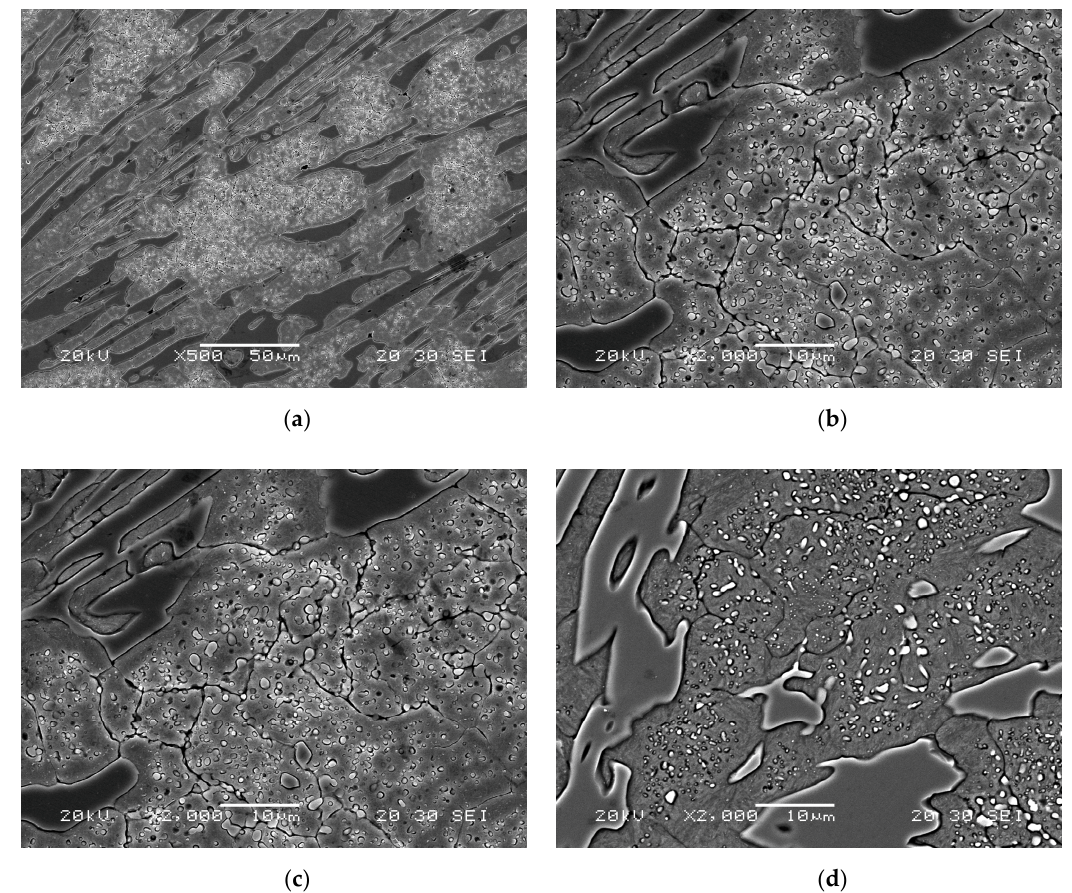
Figure 5. Comparison of the density of secondary carbides in samples subjected to destabilization heat treatments of 4 h and quenching in air or oil. Scanning electron microscope; ( a ) quenching in air. 500×; ( b ) quenching in air. 2000×; ( c ) quenching in oil. 500×; ( d ) quenching in oil. 2000×.